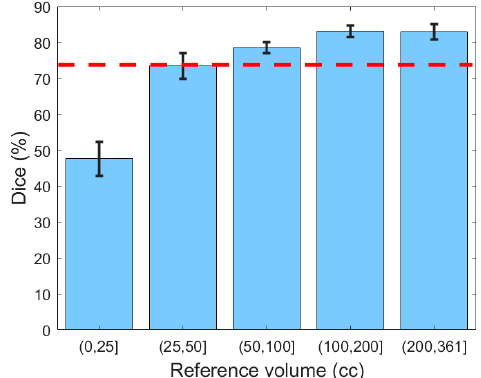
Figure 8. The Dice similarity coefficient based on the severity of hematoma. Error bars represent ±1 standard errors, the 68% confidence interval. The red dashed line indicates the human benchmark.